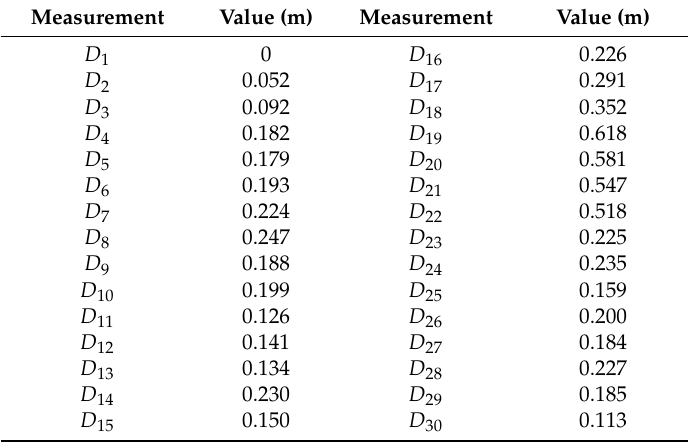
Table 5. Values of deformation obtained from the comparison between photogrammetric point clouds. An interval of 5 cm between measurements was